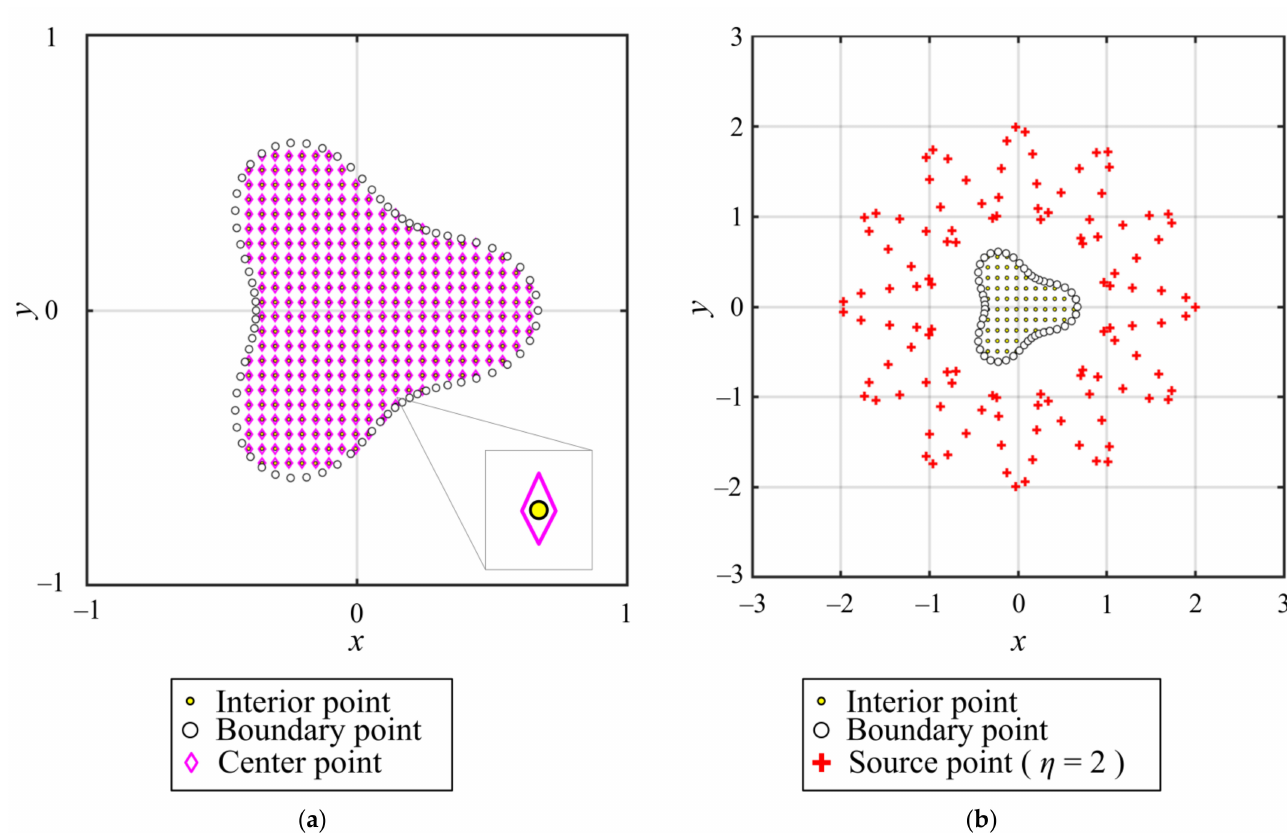
Figure 1. Location of the collocation points: ( a ) the conventional PRBF; ( b ) this